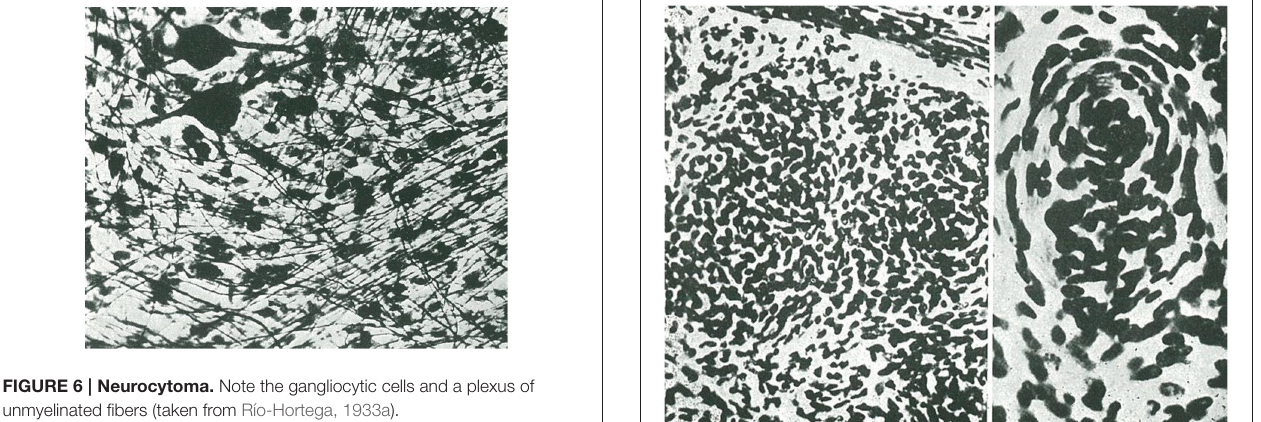
being incorporated. The most notable new additions are as